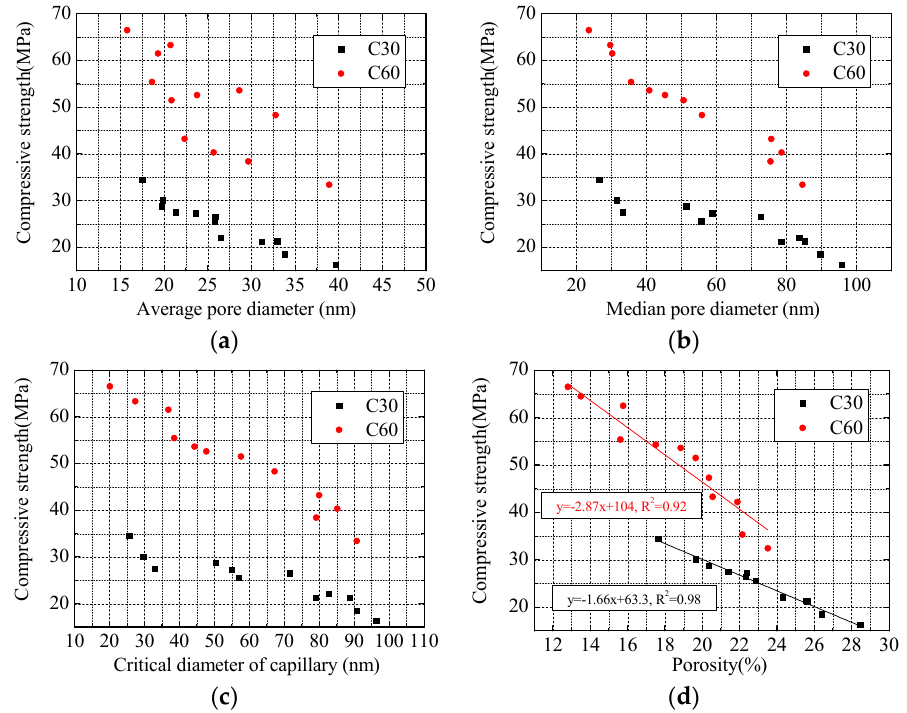
Figure 5. Relationship between compressive strength and parameters of pore structure: ( a ) average pore diameter; ( b ) median pore diameter; ( c ) critical diameter; ( d ) porosity.